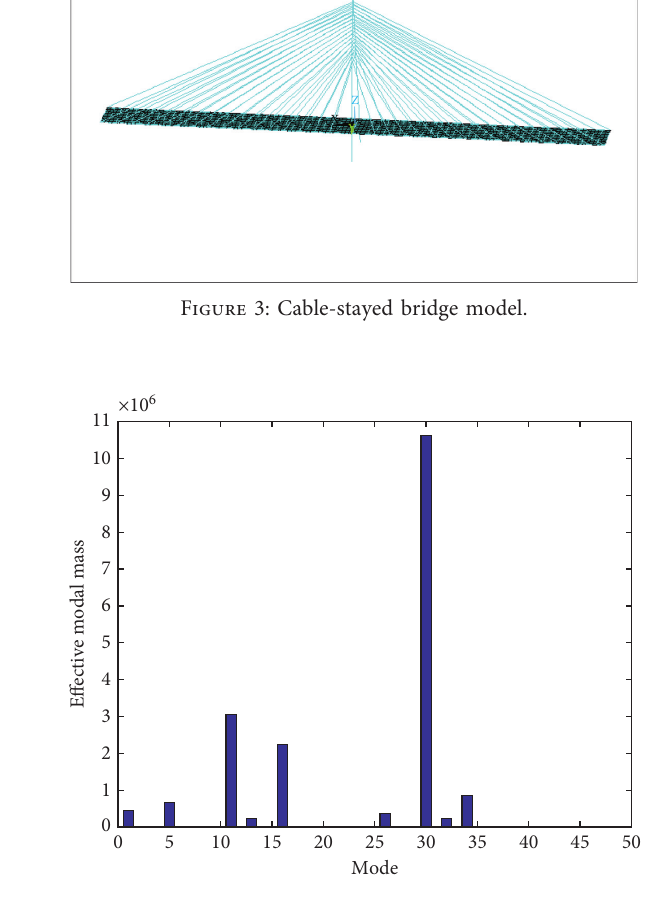
Figure 4: Effective modal mass in x direction.